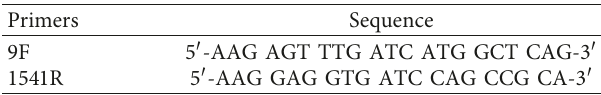
Table 1: Primers sequencing was used for PCR assay to charac- terize the strains that isolated from wounds.